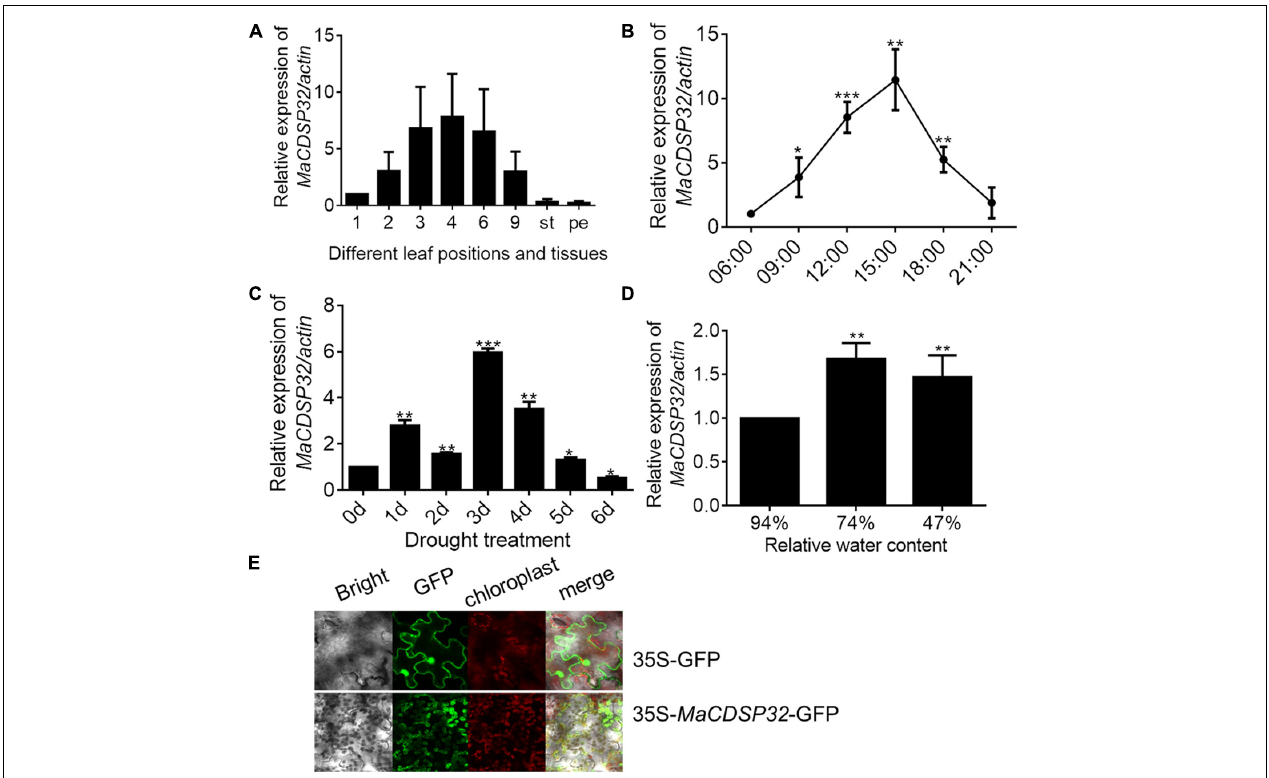
FIGURE 2 | Expression pattern of MaCDSP32 in mulberry. (A) Measurements were obtained from the aboveground parts of the ShinIchinose mulberry cultivar; 1, 2, 3, 4, 6, and 9 represent the different leaf positions from top to bottom; st, stem; pe, petiole. (B) Measurements obtained within a day. Samples were collected on 3 consecutive days (during sunny weather), with three replicate samples collected per time point. (C) Measurements obtained during 6 days of drought in Luza cultivar. (D) Measurements obtained under different relative water contents (RWCs) of leaves of the ShinIchinose cultivar. (E) Subcellular localization of MaCDSP32. The control (plasmid with 35S- GFP alone) and fusion plasmid (35S- MaCDSP32-GFP ) are shown. At least three biological replicates were included. Asterisks indicate significant differences between the transgenic and wild-type leaves ( t -test, * P < 0.05, ** P < 0.01, *** P <